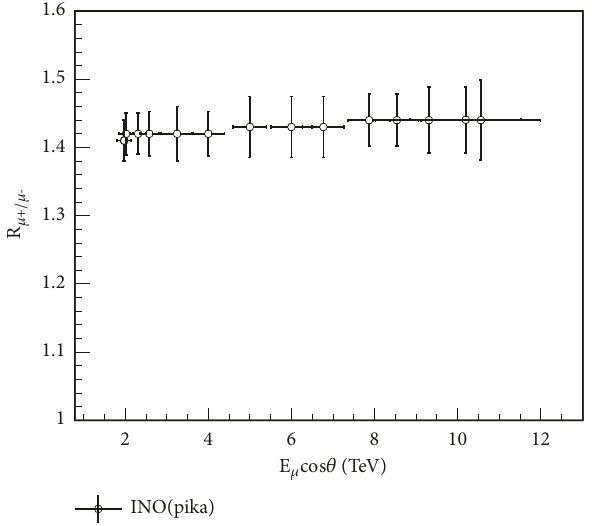
Figure 13: Muon charge ratio with systematic errors at the INO- ICAL detector as a function of surface muon energy, obtained using the “pika”